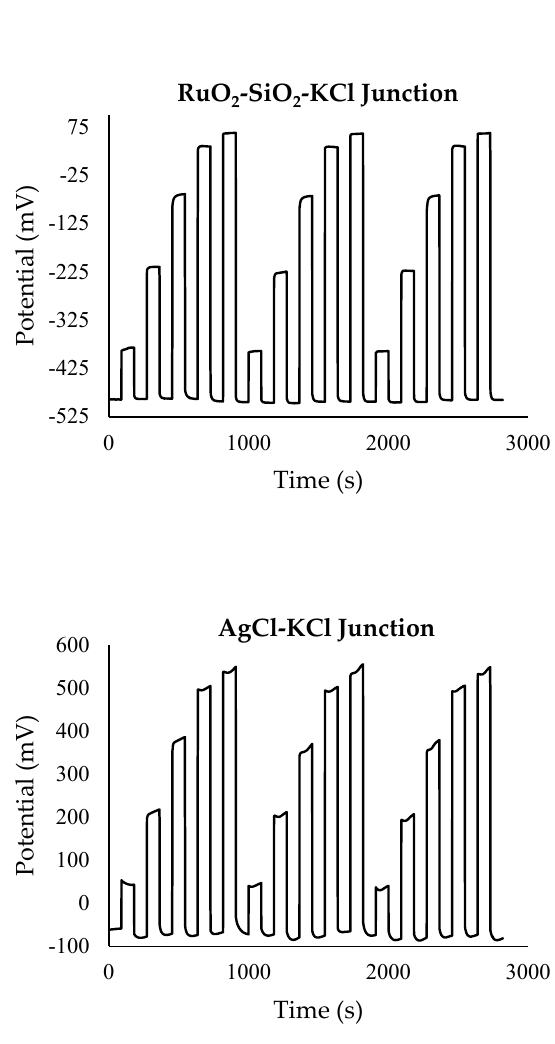
Figure 3. pH 12–10–7–4–2–1 data loops, with pH 12 between each measurement, for RuO 2 pH sensors with Glued-RuO 2 , RuO 2 -SiO 2 , RuO 2 -SiO 2 -KCl, and AgCl-KCl reference electrodes.